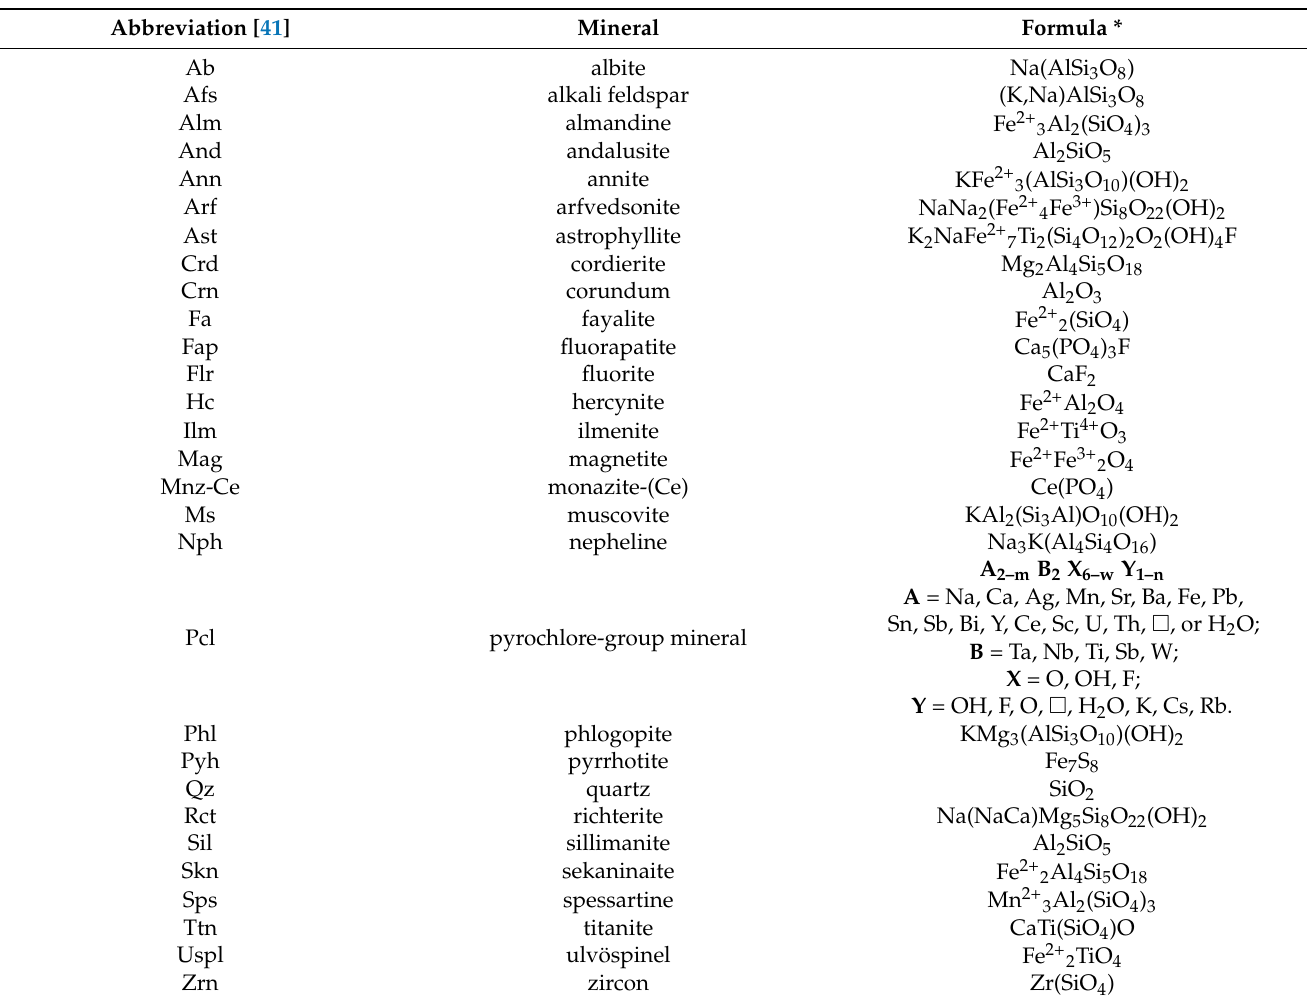
Table 2. Mineral